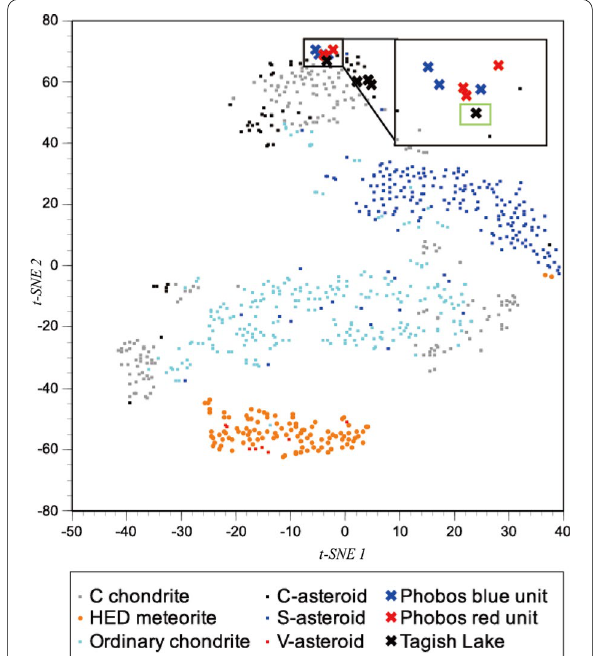
Fig. 2 Correlation‑based mutual distances of 556 meteorites, 259 asteroids, and Phobos’s blue and red units visualized by t‑SNE approach, which shows the correlations between C‑type asteroids and C‑type meteorites. Colors represent types of asteroids and meteorites as denoted in the bottom. Inset is the closeup of the upper middle part of the plot, which shows both the red and the blue units of Phobos is best matched with the Tagish Lake meteorite, which is surrounded by the greenish